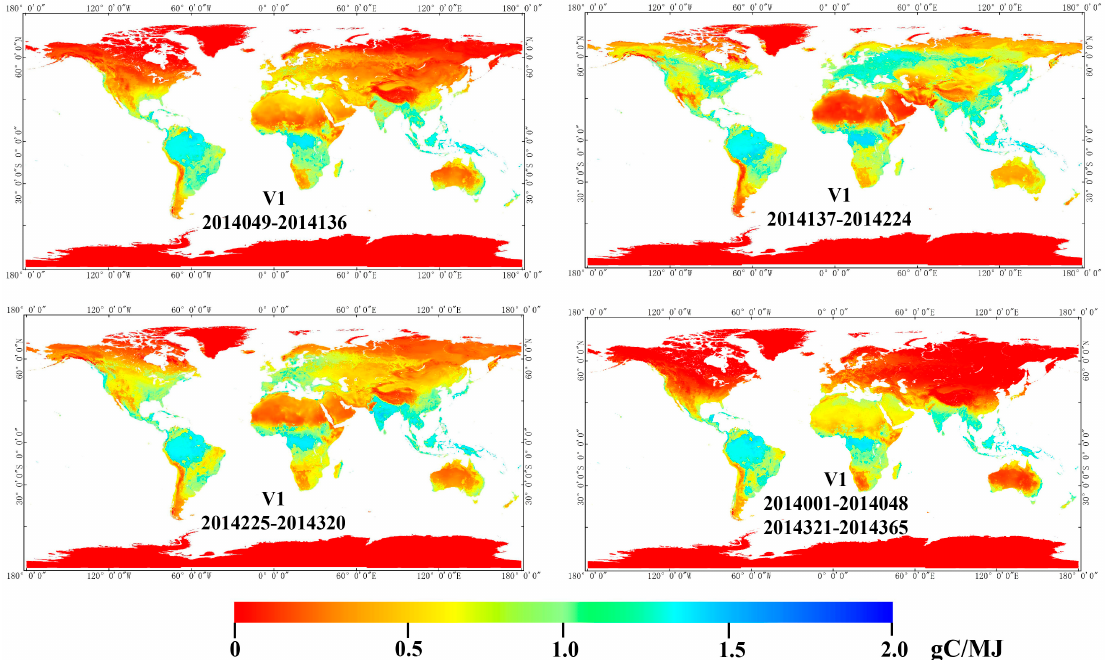
Figure 5. The distributions of LUE by parameterization approach without the CI (V1).